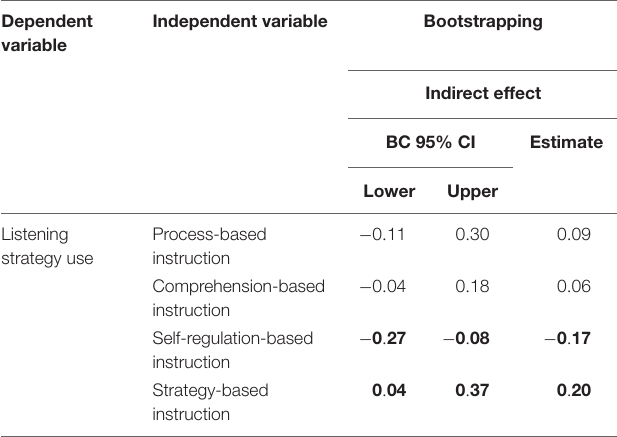
TABLE 4 | The significance of the mediating effect of self-efficacy between listening instruction and strategy